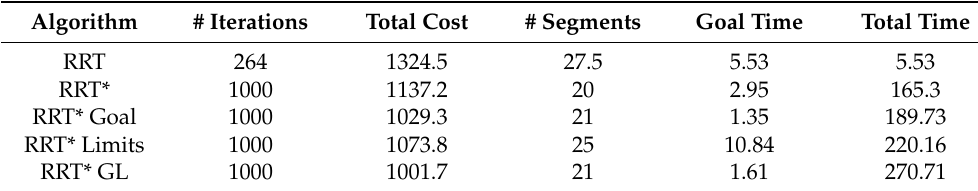
Table 12. Results. Three obstacles, 1000 iterations.